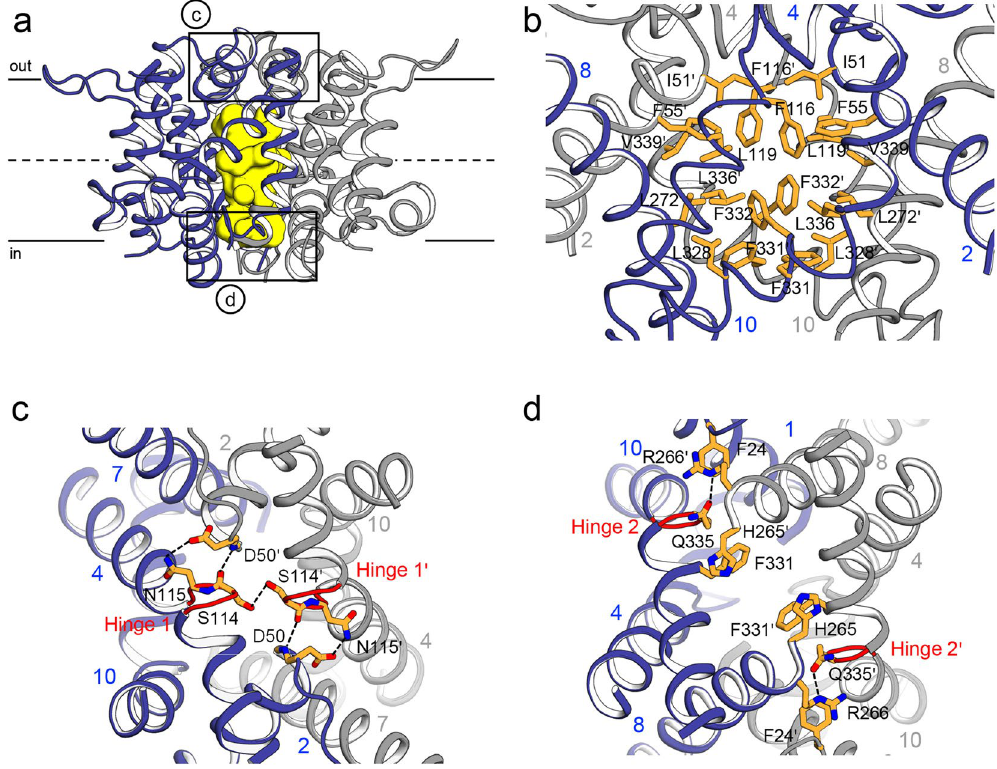
Figure 2. The interface of the Kp CitS homodimer. ( a ) Ribbon representation of the dimerization domains. The hydrophobic cavity is highlighted in yellow. The two areas enlarged in ( c , d ) are boxed. The dimerization domains in one dimer are shown in blue and grey, respectively. ( b ) The shape of the central cavity in the dimerization interface, and the residues lining the cavity. The view is rotated by 90 degrees along the vertical axis from that of ( a ). ( c ) Residues involved in stabilizing the dimer interface on the periplasmic side of Kp CitS. ( d ) Residues involved in dimer stabilization on the cytoplasmic side of Kp CitS. The hinge 1 and 2 regions on TM 4 and TM 10, respectively, are highlighted in